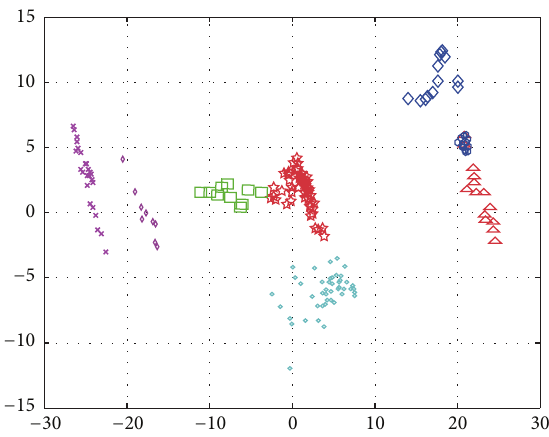
Figure 12: Clustering results obtained by KMRIC.